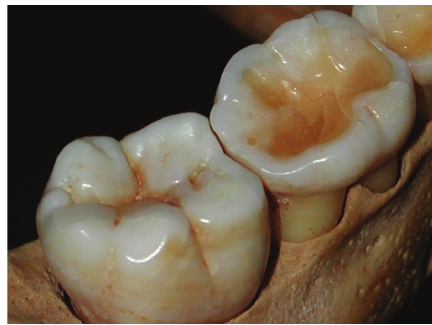
Figure 1: Interproximal wear in a young child. The mesial of the permanent first lower molar wears faster than the distal of the primary second molar.